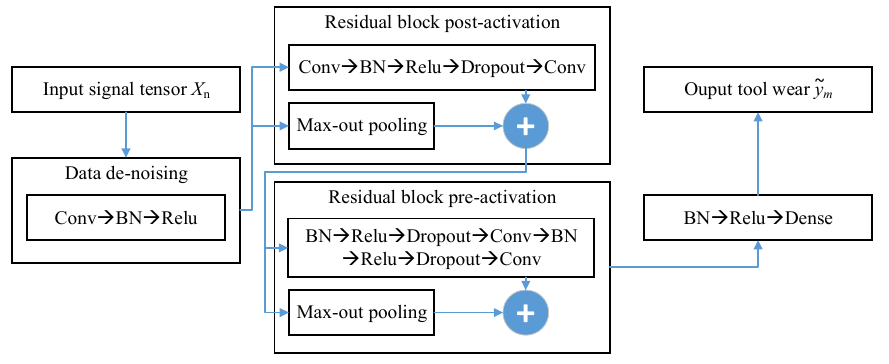
Figure 5. ResNet-based model.